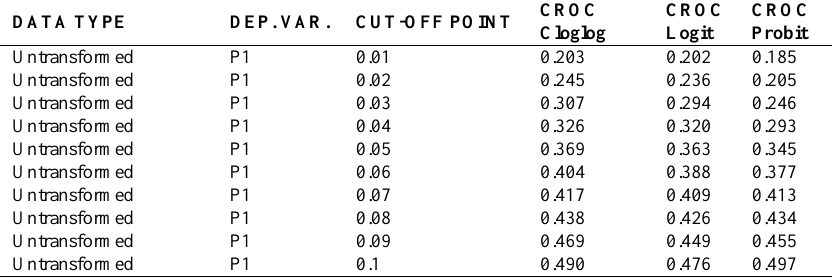
Table 5. Selection of the optimal cut-off point based on the CROC criterion. The